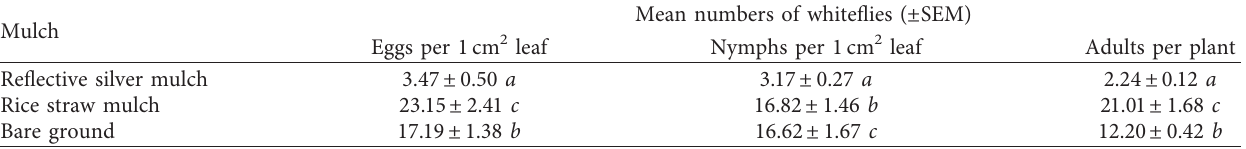
Table 1: Mean numbers of whitefly eggs, nymphs, and adults for mulch type treatments, 2018.